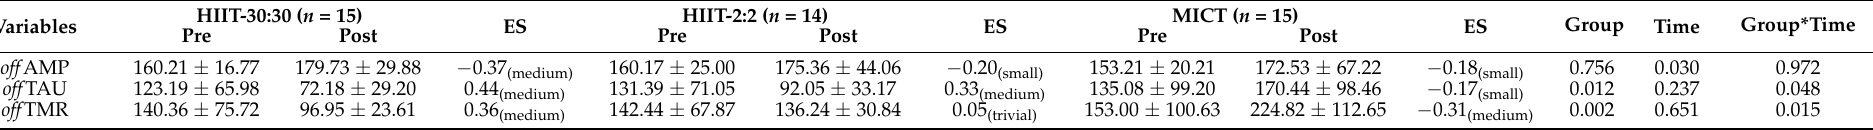
Table 3. Evaluation of HR kinetics at the beginning and end of the intervention